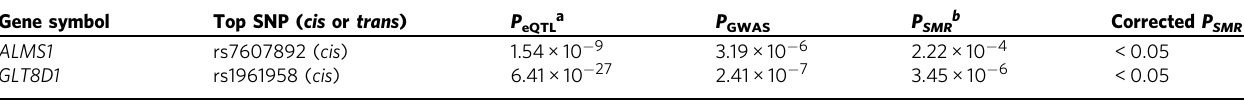
Table 3 Validation of ALMS1 and GLT8D1 as schizophrenia risk genes using independent integrative analysis method ( SMR )